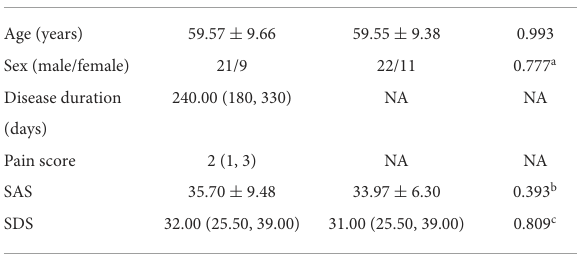
TABLE 1 Demographic and neuropsychological data comparisons.